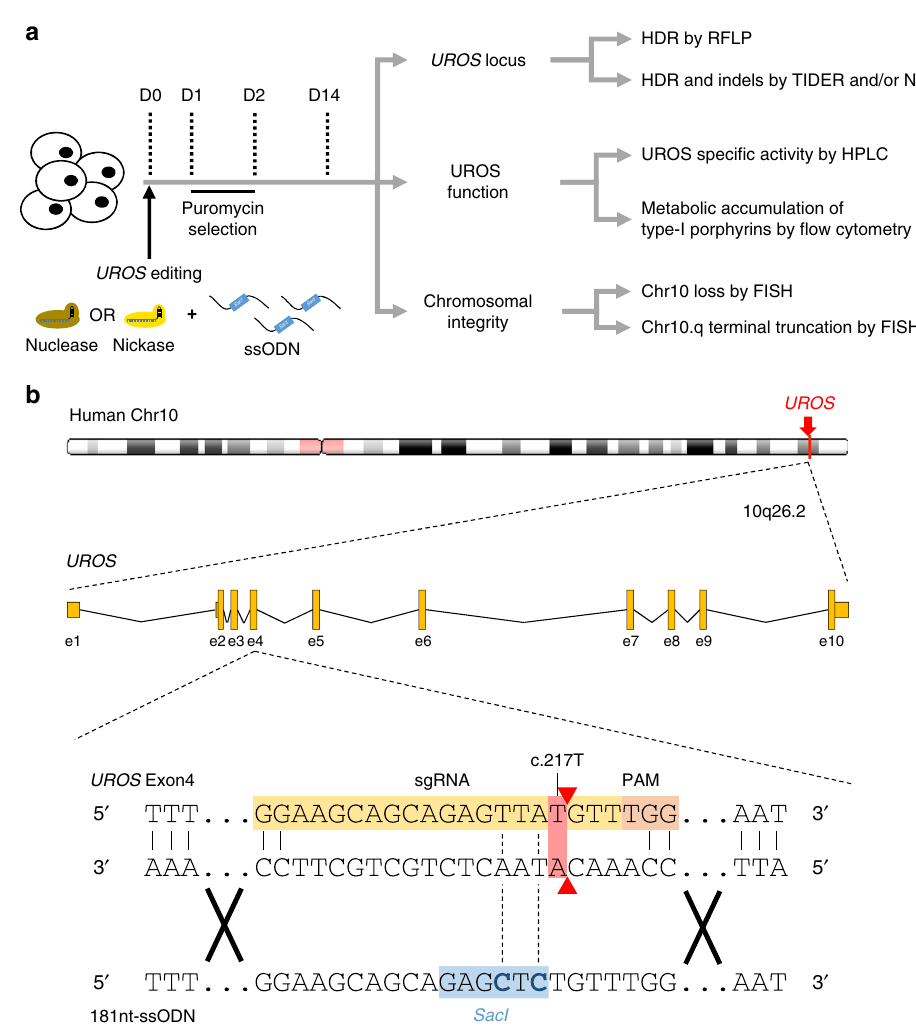
Fig. 1 UROS gene editing strategy and work fl ow analysis. a Experimental work fl ow for UROS gene editing and analysis of outcomes. Cells were nucleofected with the 181nt-ssODN template and either with nuclease or nickase followed by puromycin-positive selection. Then, (i) UROS locus was characterized by RFLP to quantify HDR and by TIDER or deep sequencing to evaluate indels and to con fi rm HDR percentage; (ii) UROS functionality was assessed by quantifying UROS-speci fi c activity and type-I porphyrin accumulation, respectively determined by HPLC and fl ow cytometry; (iii) Chromosomal integrity was tested for Chr10 loss or Chr10q terminal deletion either by DNA-FISH assay or array-CGH. b (Top) Schematic UROS locus in chromosome 10 with UROS gene overview (middle). (Bottom) Detailed view of exon 4 region and CRISPR-mediated HDR design using a c.217T-targeting sgRNA (highlighted in orange) with adjacent PAM and an 181nt-ssODN carrying a silent SacI restriction site (highlighted in blue) close to c.217 T position. Red arrows indicate expected cleavage site using nuclease. Chr chromosome, CGH comparative genomic hybridization, D day, e exon, HDR homology-directed repair, HPLC high performance liquid chromatography, NGS (next-generation sequencing), RFLP (restriction fragment length polymorphism), PAM protospacer adjacent motif, sgRNA single guide RNA, TIDER (tracking of insertions, deletions and recombination